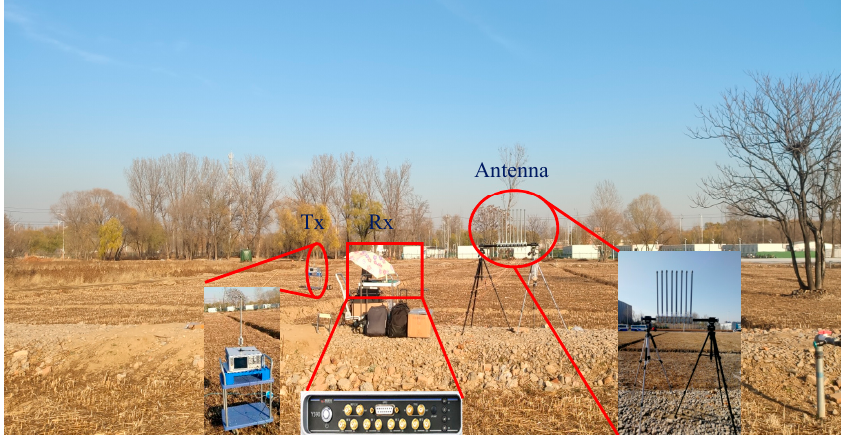
Figure 7. Photo taken during the measurement campaigns of the outdoor scenario pointing out the positions of the transmitter and the antenna array-based receiver.